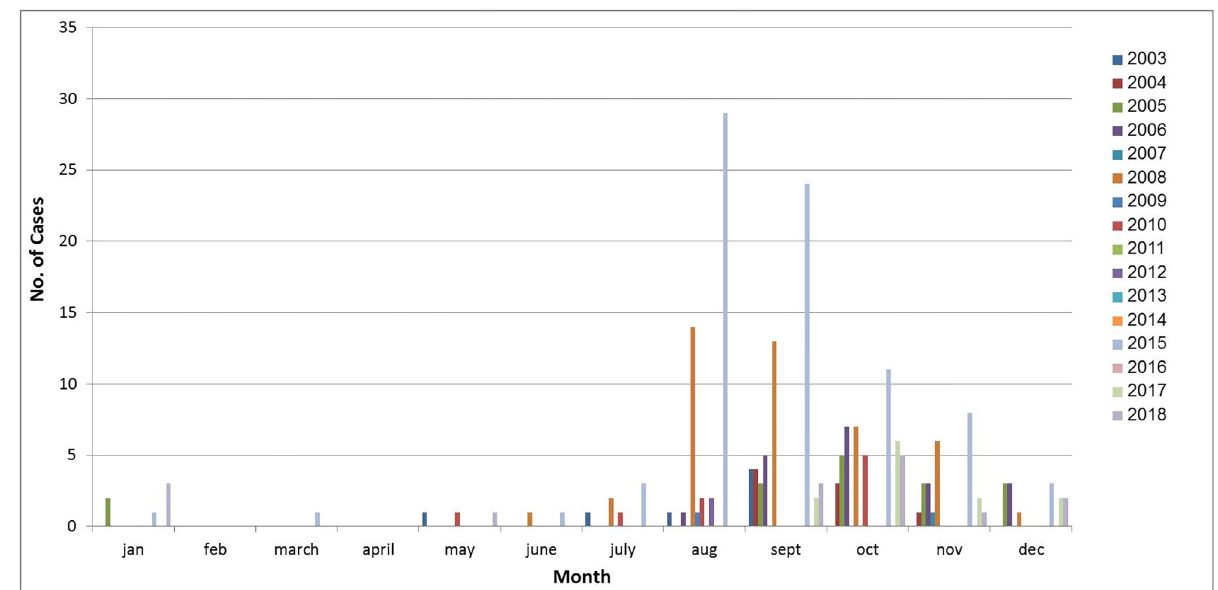
Fig 6. Cryptosporidium cases per month in Haifa and West Galilee HMO 2003–2018. The number of cases per month in the years 2003–2018 are shown (national database).